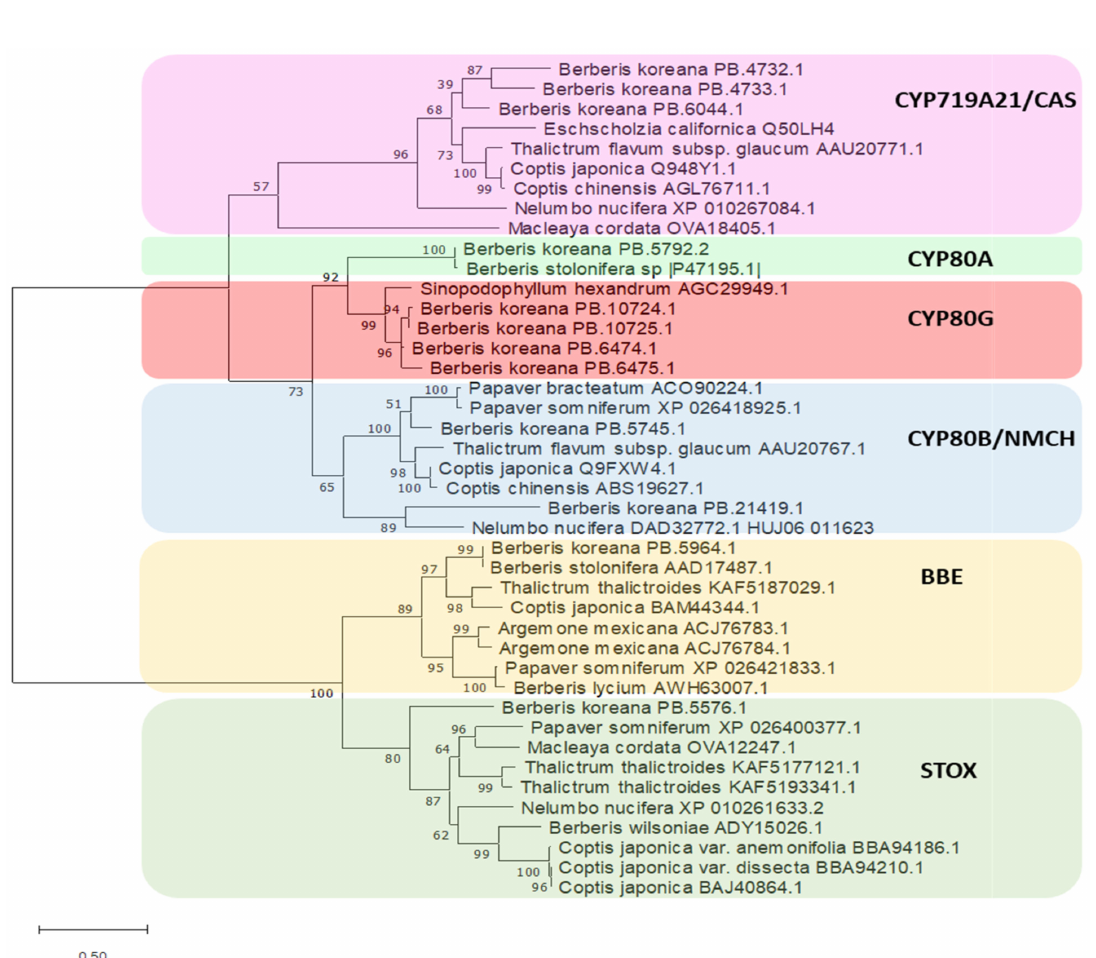
Figure 6. Phylogenetic tree generated using maximum likelihood for CYPs and oxidases based on the deduced amino acid sequences for the B. koreana sequences. GenBank accession numbers for the sequences used are as follows: Sinopodophyllum hexandrum AGC29949.1, Papaver bracteatum ACO90224.1, Papaver somniferum XP_026418925.1, Thalictrum flavum subsp. glaucum AAU20767.1, Coptis japonica Q9FXW4.1, Nelumbo nucifera DAD32772.1 HUJ06_011623, Coptis chinensis